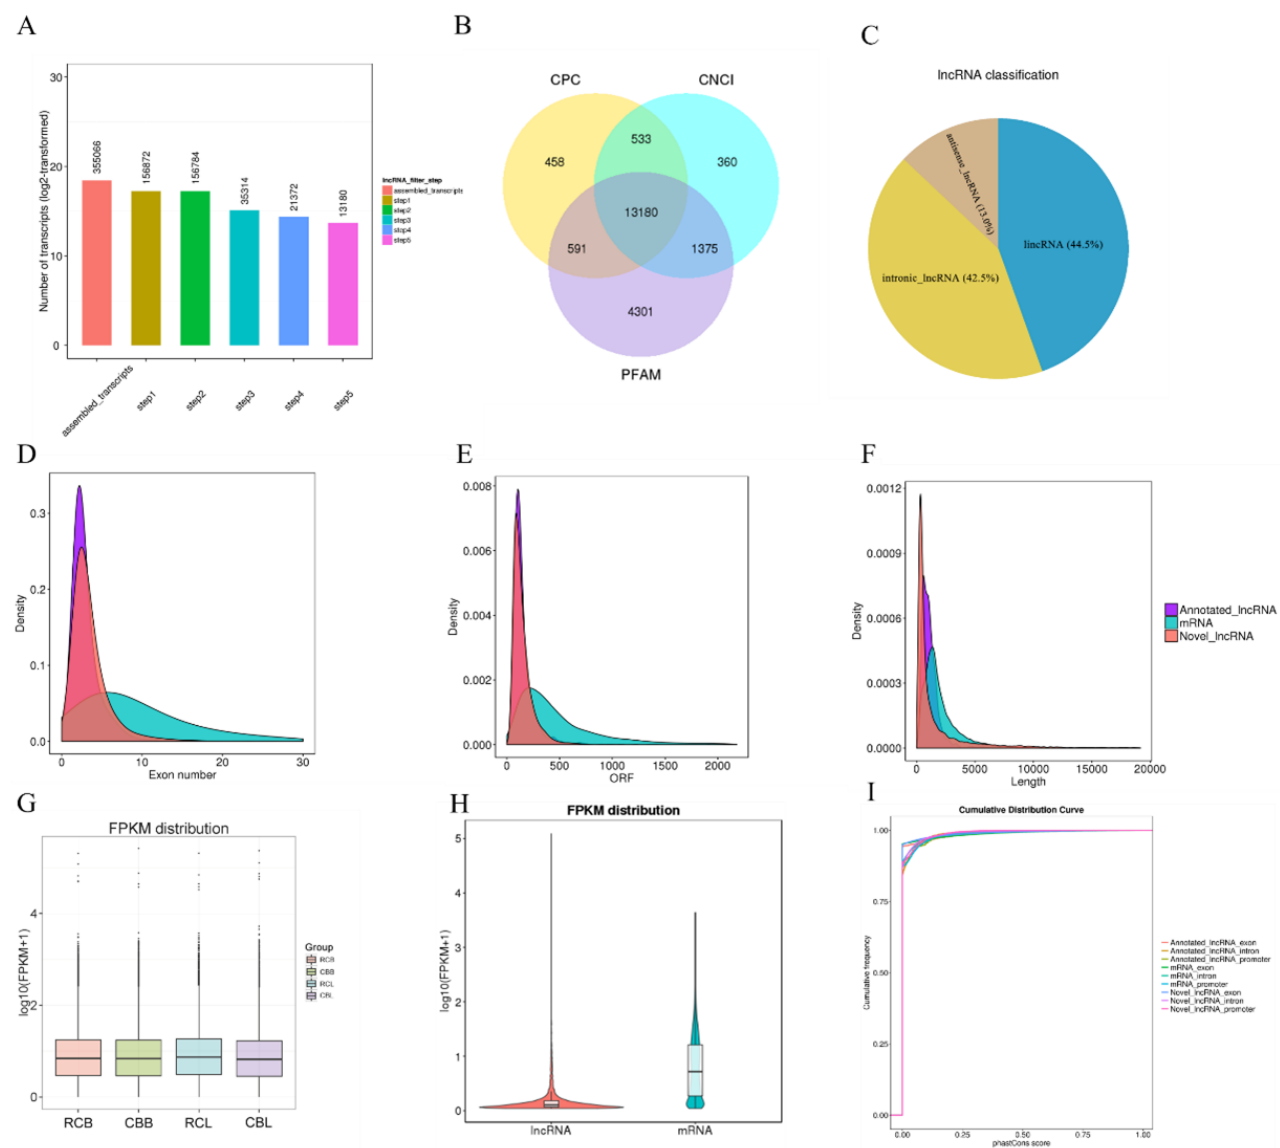
Figure 2. Screening and characteristics of lncRNAs and mRNAs. (A) A total of 355,066 transcripts were assembled by using Cufflinks with a strin - gent filtering pipeline to discard transcripts without all the characteristics of lncRNAs. (B) Identification of lncRNAs by using CPC, CNCI, and PFAM. A total of 13,180 transcripts were identified by the three software programs, and both protein-coding transcripts and putative protein-cod - ing transcripts were removed. (C) Classification of novel lncRNAs. (D) Exon numbers, (E) ORF length distributions and ORF sequences of lncRNAs predicted by EMBOSS: getorf. (F) mRNA, annotated lncRNA and novel lncRNA lengths. (G) Box plot of the expression levels of lncRNAs in four li - braries (shown in log10 (FPKM+1)). (H) Violin plot of the expression levels of mRNAs and lncRNAs (shown in log10 (FPKM+1)). (I) Conservation scores of mRNAs, annotated lncRNAs and novel lncRNAs. ORF, open reading frames; FPKM, fragments per kb of transcript per million mapped